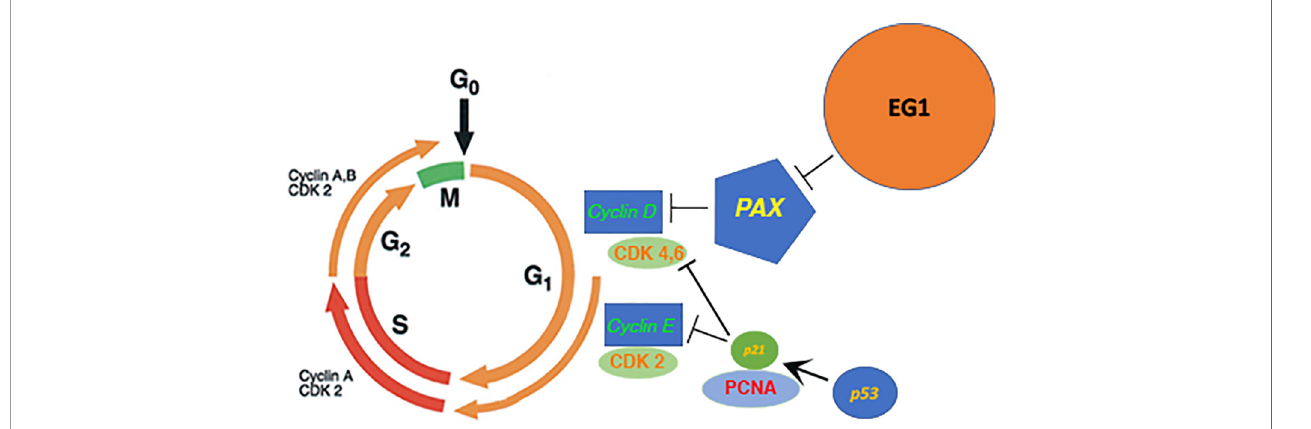
FIGURE 10 | Proposed model of the downstream effect that EG1 has on cell cycling via PAX inhibition. The EG1 compound is expected to block the interaction between the PAX transcription factors and DNA which causes a loss of polymerase recruitment to the site and a reduction of PAX regulated gene transcription resulting in the disruption of cyclin dependant kinase (CDK) activation. A reduction of CDK activity will cause a loss of cell signalling and thus interrupts the normal cell cycling